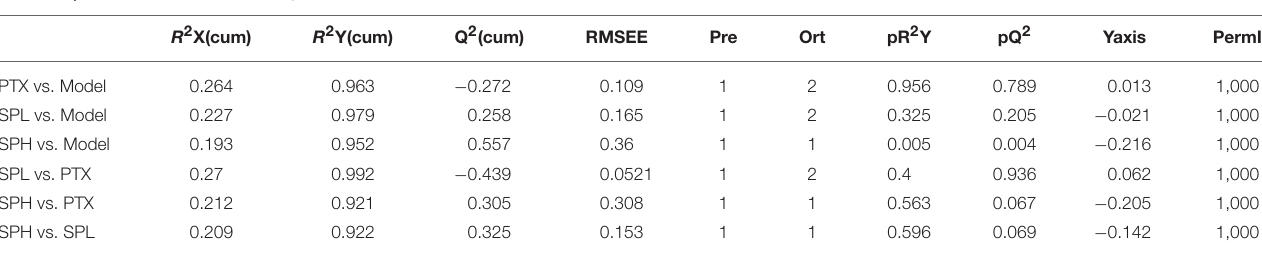
TABLE 2 | Results of OPLS-DA model